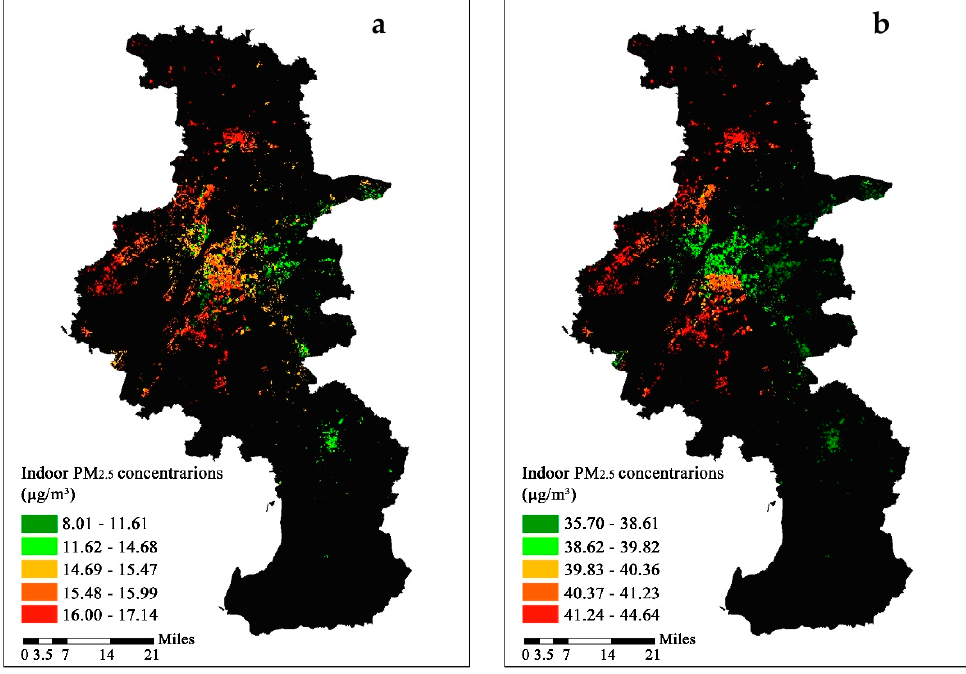
Figure 7. The spatial distributions of annual indoor PM 2.5 concentrations estimated from outdoor PM 2.5 concentrations. ( a ) Scenarios 1 and ( b ) Scenarios 2.